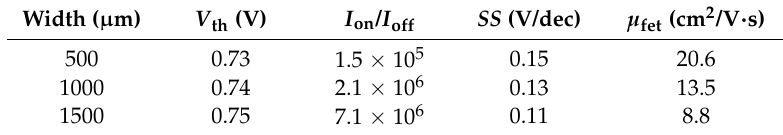
Table 2. The performance parameters of a -IGZO TFTs with Si 3 N 4 gate dielectric. Width ( µ m) V th (V)